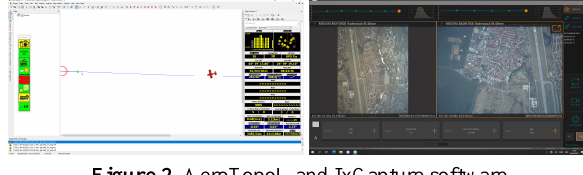
Figure 2 . AeroTopoL and IxCapture